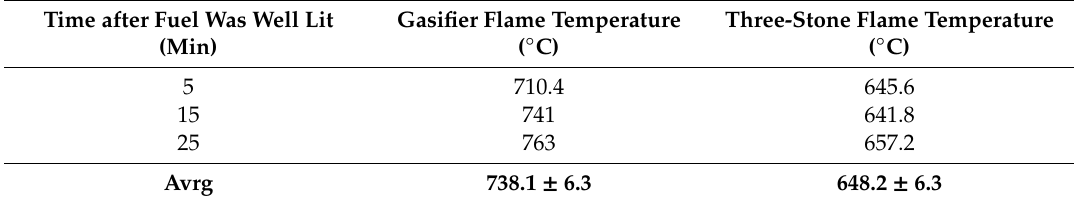
Table 7. Flame temperature of the gasifier and three-stone open